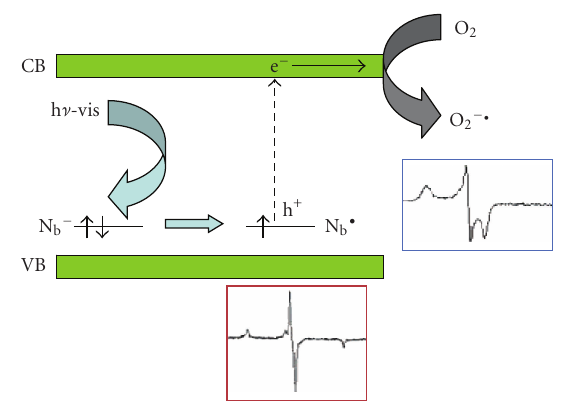
Figure 9: Sketch of the proposed mechanism for the processes in- duced by vis-light irradiation of the N-doped sample in O 2 atmo- sphere. Reproduced with permission from [50]. Copyright (2006) American Chemical Society.